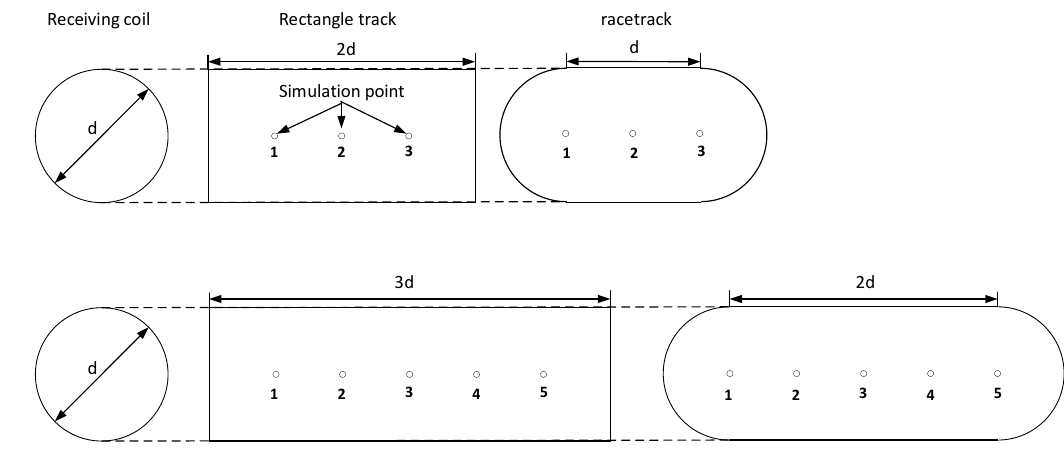
Figure 5. Schematic diagram of shape and size of receiving coil and tracks. Table 2. Simulation related parameters.